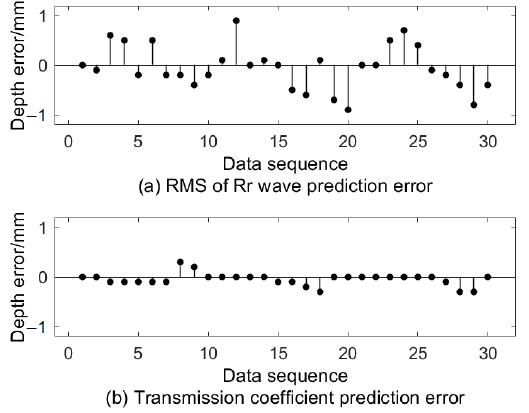
Figure 14. ( a ) SVM prediction error with the root mean square of the Rr wave; ( b ) SVM prediction error with transmission coefficient.